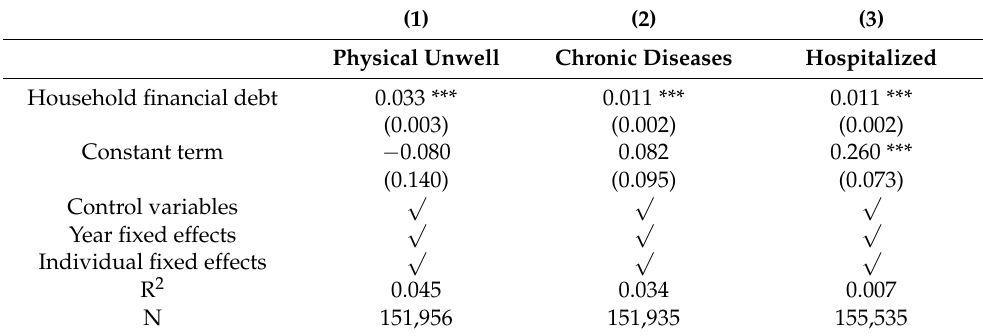
Table 5. Regression results after replacing the explanatory variables.